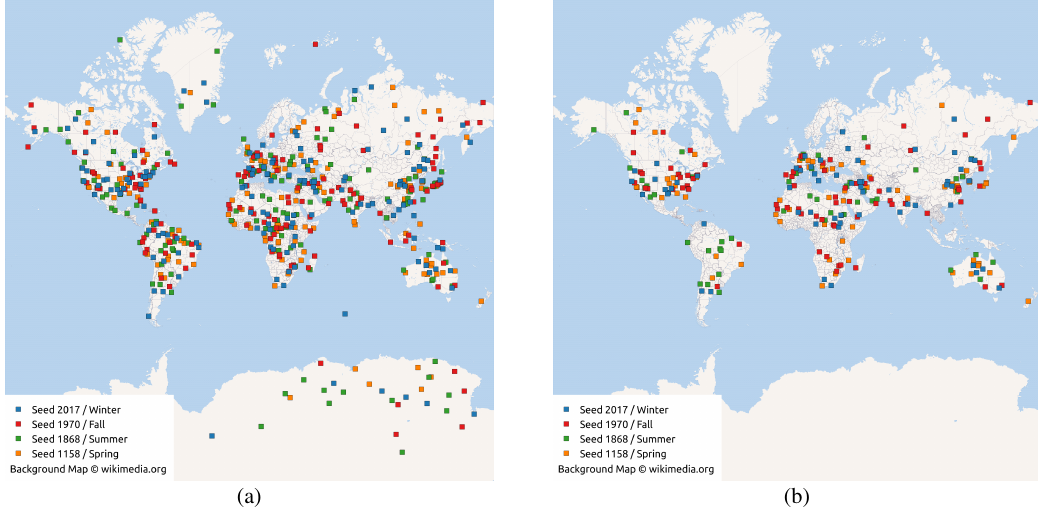
Figure 2. Distribution of the ROIs sampled uniformly over the land masses of the Earth: (a) Original ROIs, (b) final set of scenes after removal of cloud- and/or artifact-affected